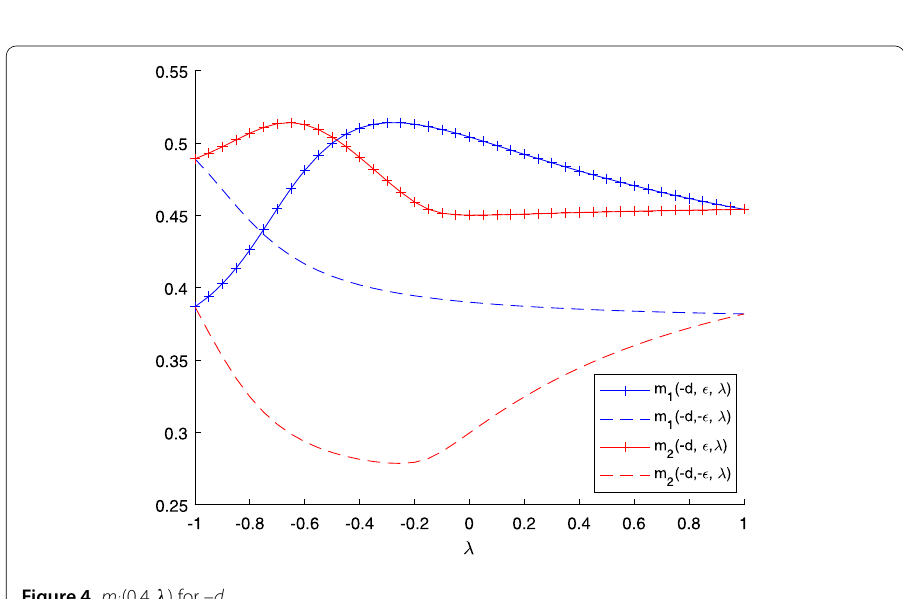
Figure 3 m i (0.4, λ ) for d